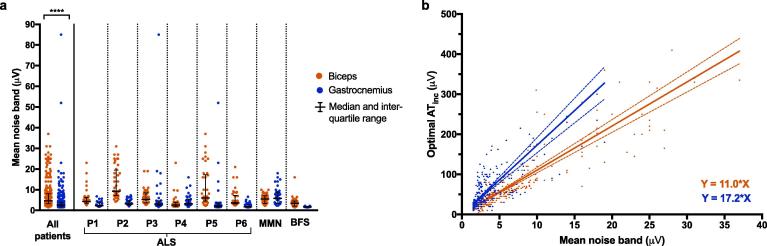
Noise level analysis (phase one). (a) Distribution of mean noise bands for biceps and gastrocnemius. Each data point represents one minute of recording. There was a significant difference in noise levels between biceps and gastrocnemius (p < 0.0001, Mann-Whitney test). (b). Relationships between mean noise band and optimal ATinc. ATinc was calculated from manual counts using 10 s windows. The best-fit lines were calculated with weighted least-squares regression due to heteroscedasticity of the data. For biceps (red), n was 295 and r2 was 0.648. For gastrocnemius (blue), n was 304 and r2 was 0.402. (For interpretation of the references to colour in this figure legend, the reader is referred to the web version of this article.).